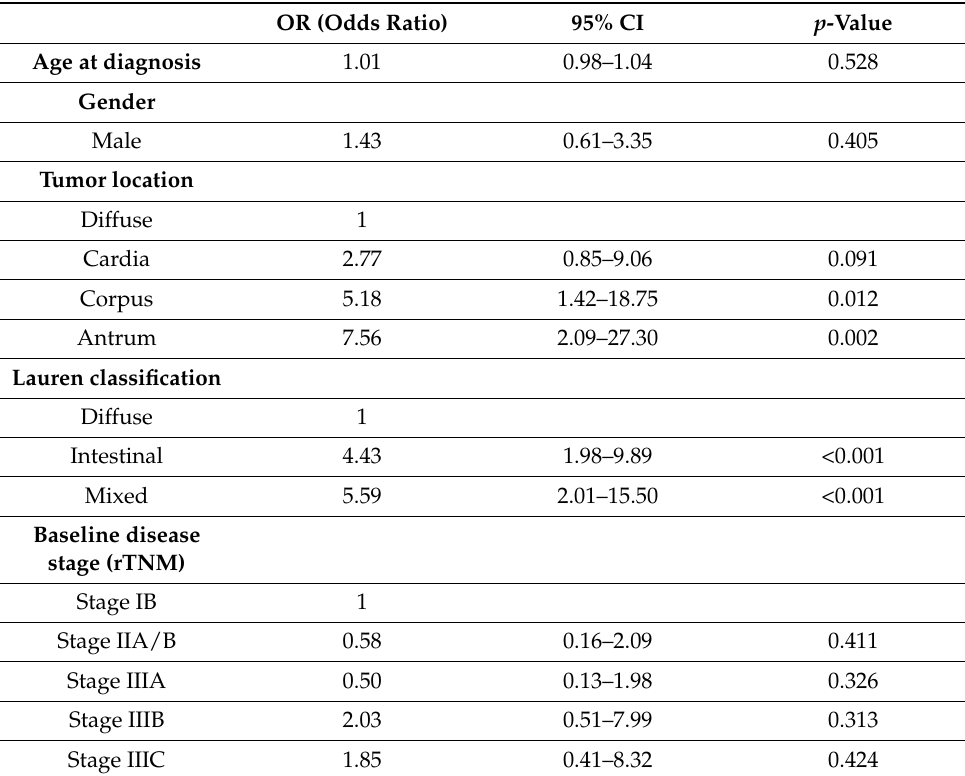
Table 2. Ordinal cumulative logistic regression with TNM response mode as the dependent variable, and entering age, gender, tumor location, Lauren histological type, and disease stage at diagnosis as the explanatory variables *.